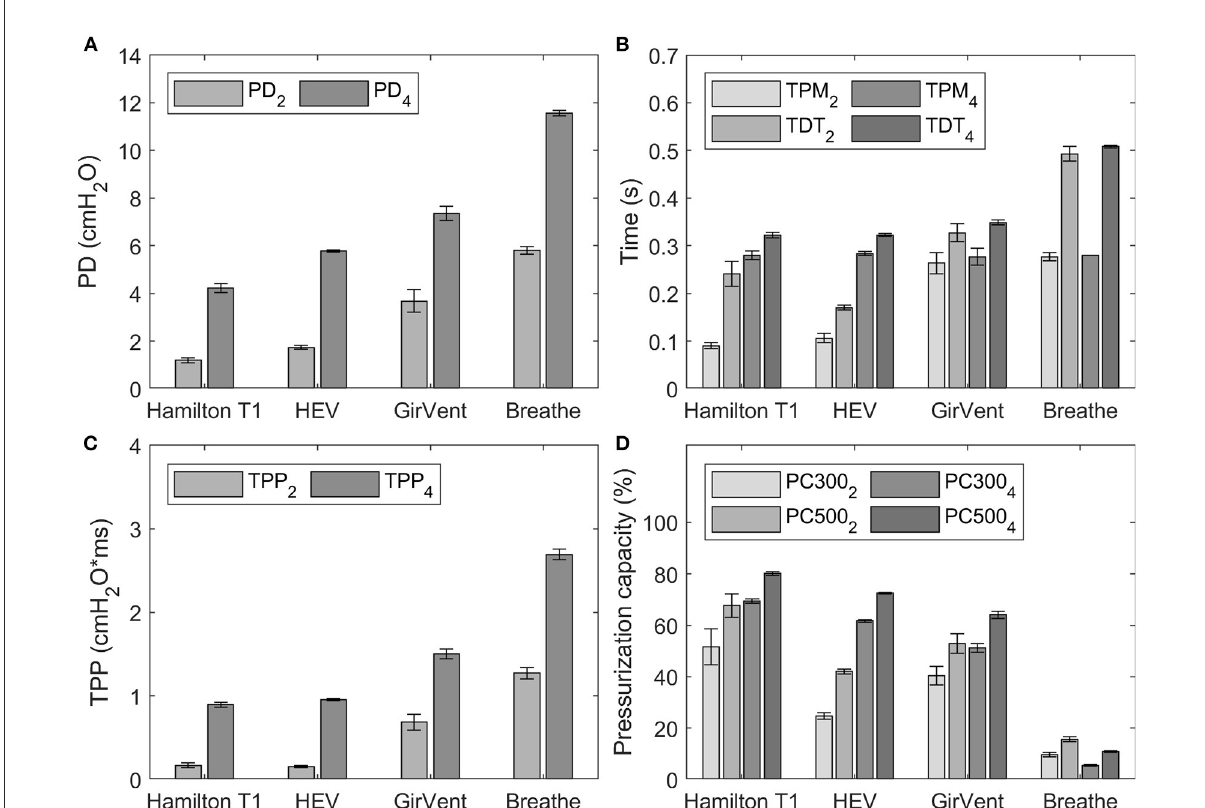
FIGURE7 Results of the trigger characteristics for occlusion pressure values (P0.1) of 2 cmH 2 O/100ms and 4 cmH 2 O/100ms, indicated by the subscript in the corresponding legend. Error bars indicate the standard deviation. (A) pressure drop (PD), (B) time to pressure minimum (TPM) and trigger delay time (TDT), (C) time pressure product (TPP), and (D) pressurization capacity after 300ms and 500ms (PC300 and